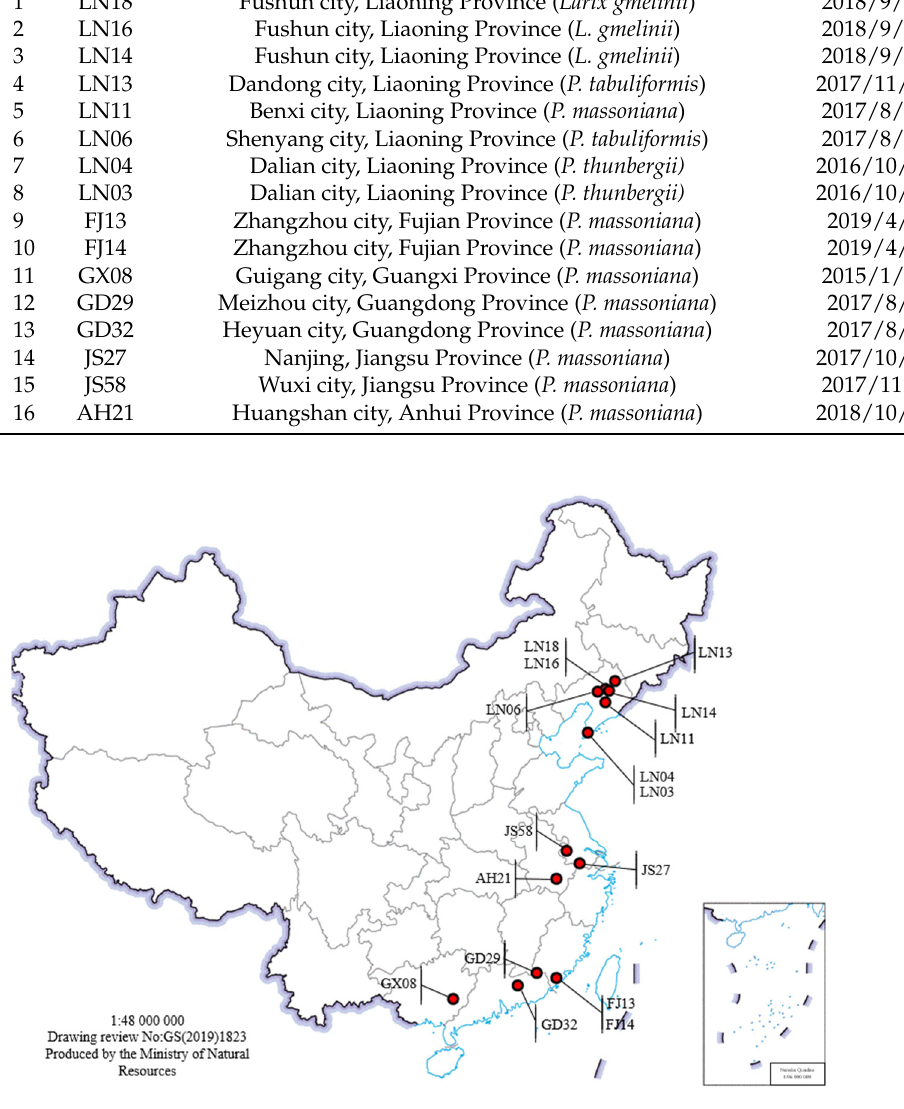
Figure 1. Sampling locations for 16 strains. The red dot on the map represents the sampling loca- tion of the corresponding strain. The sampling locations of LN16 and LN18, LN03 and LN04, FJ13 and FJ14 are very close. All strains were isolated from different pine trees and different forest stands.